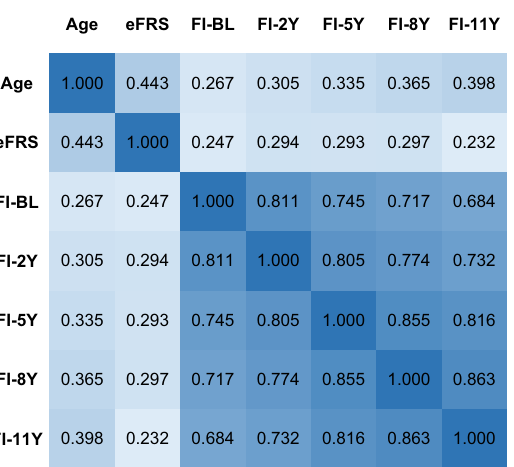
study). eFRS epigenetic frailty risk score, FI-BL baseline frailty index, FI-2Y 2-year follow-up frailty index, FI-4Y 4-year follow-up frailty index, FI-5Y 5-year